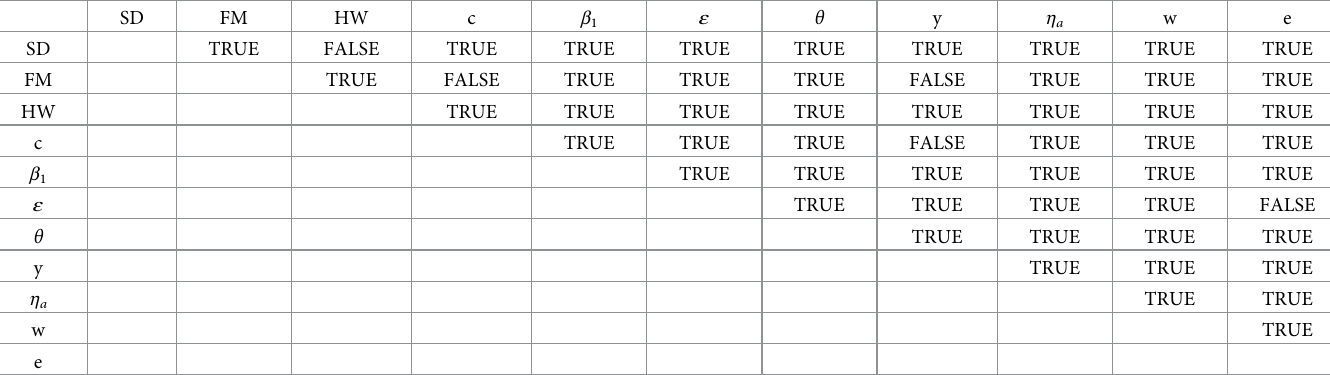
Table 8. Summary of different pairs of significant parameters by accounting for the false discovery rate.